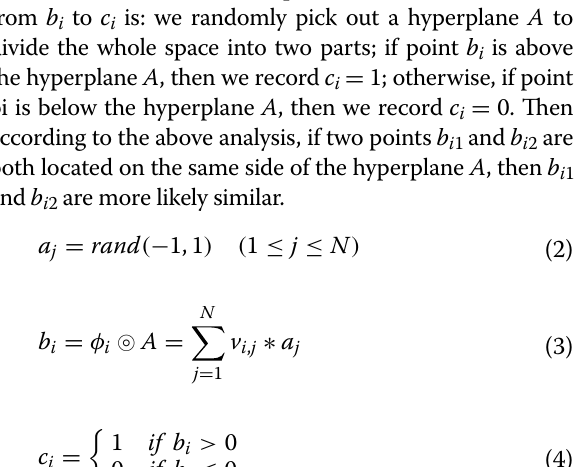
Fig. 2 Main procedure of the proposed FSPLO